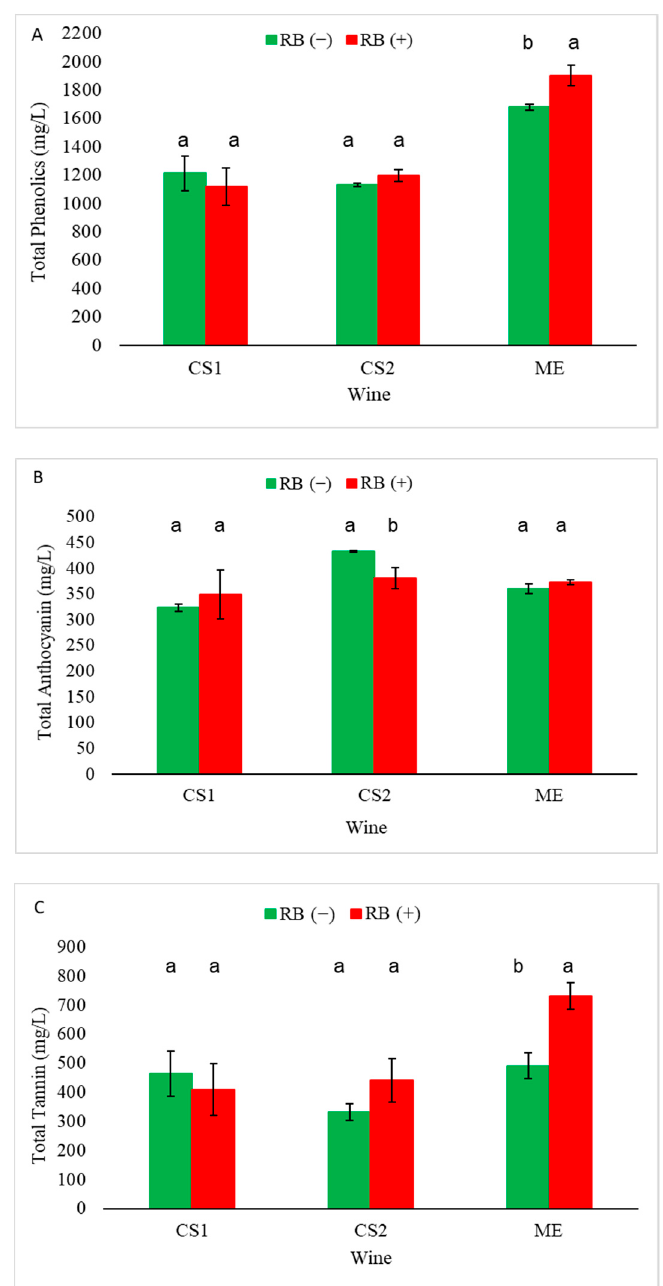
Figure 1. Cabernet Sauvignon Site 1 (CS1), Cabernet Sauvignon Site 2 (CS2), and Merlot (ME) total phenolics ( A ), total anthocyanins ( B ), and total tannin ( C ) concentration of 2014 wines (n = 3 for S2 and n = 2 for CS1 and ME, p < 0.05). Statistical differences are expressed as letters and indicate significant differences in the LSD test for each site.